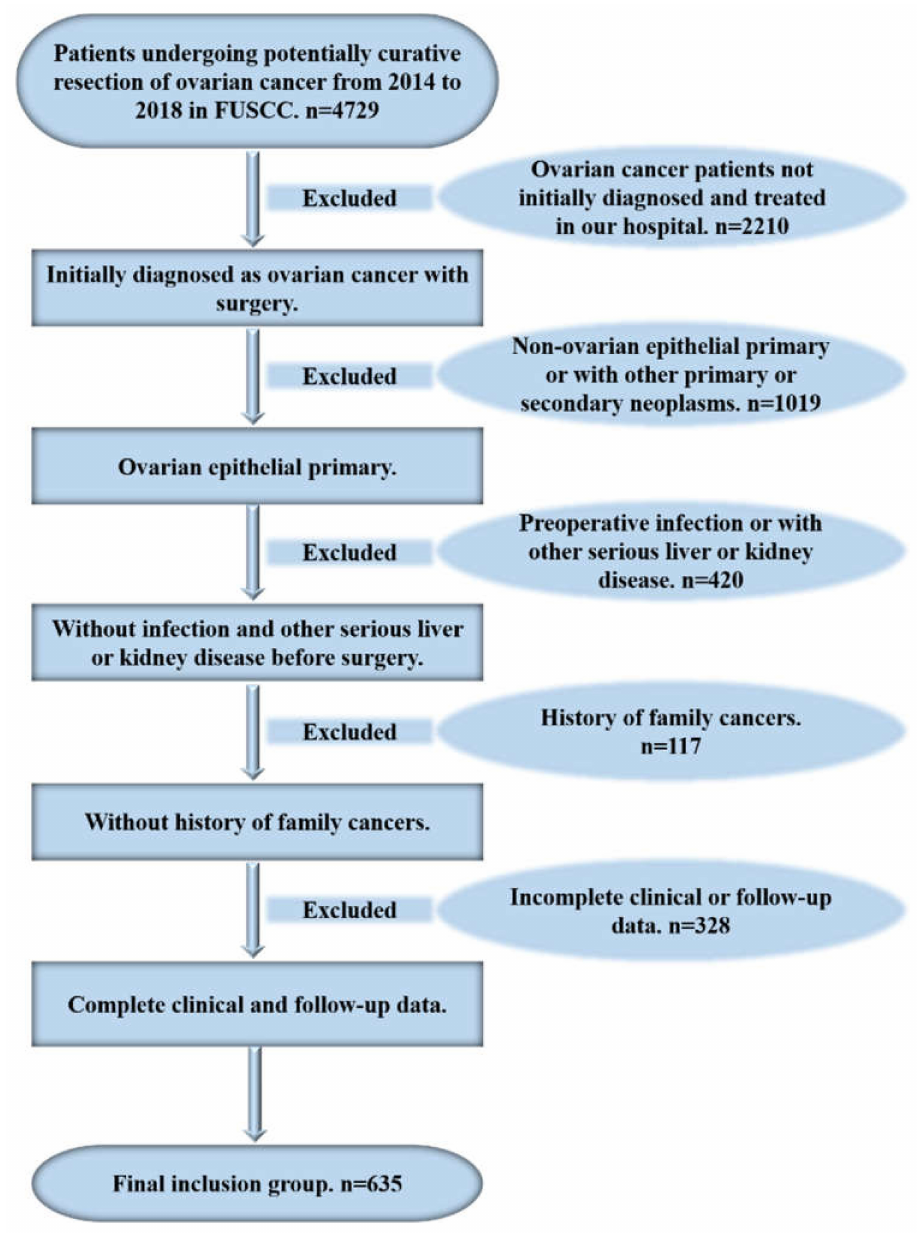
Figure 1. The flow chart of patients in the 5-year cohort to obtain the analytical